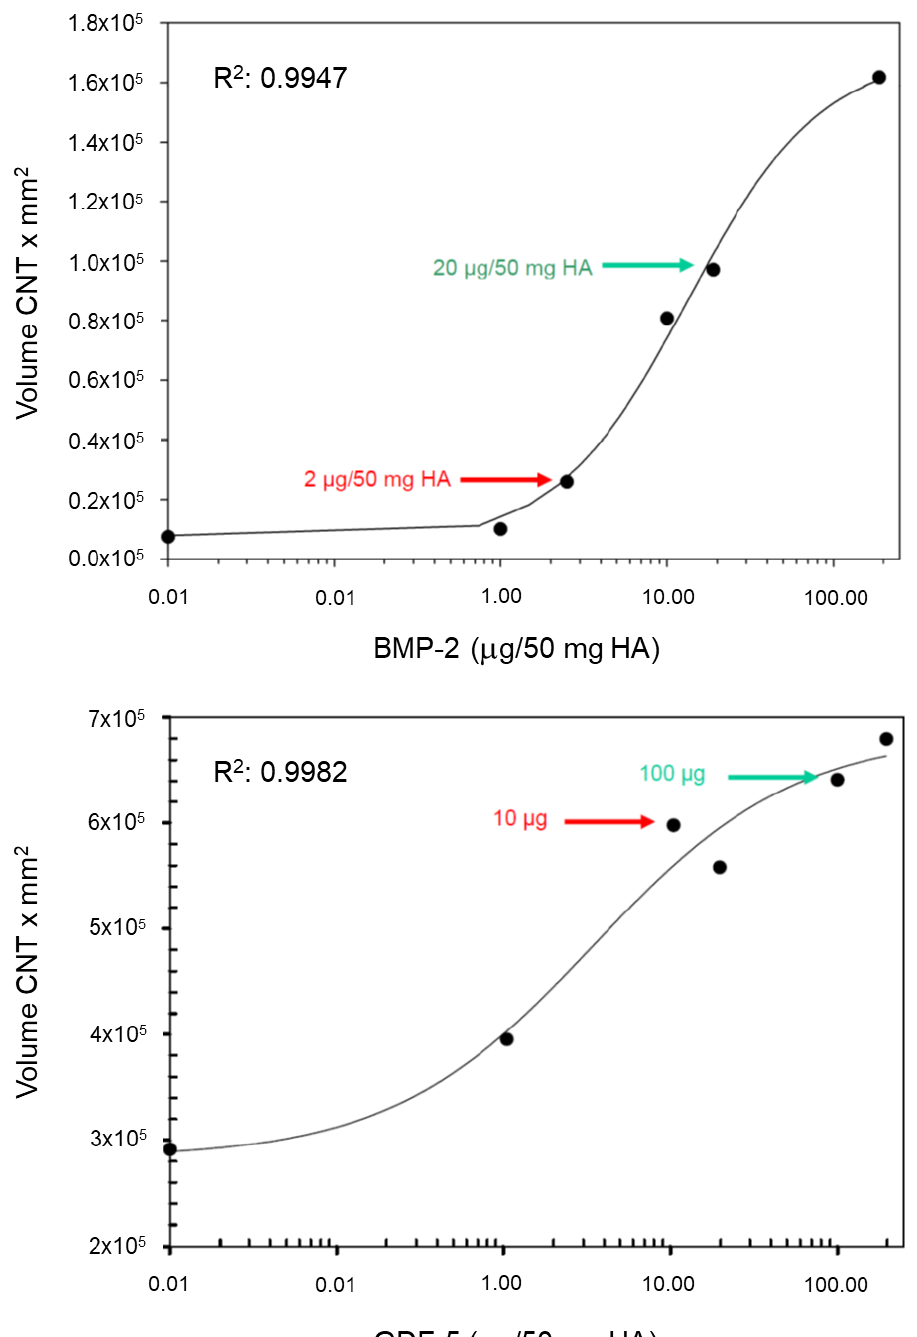
Figure 2. In vitro evaluation of the dosages for BMP-2 (C2C12 cell line; upper panel) and GDF-5 (ATDC-5 cell line; lower panel) for application in animal experiments by direct coculture with the growth-factor-coated HA particles for 3 days and subsequent determination of their alkaline phosphatase (ALP) activity ( n = 3–4 experiments each; one representative result is shown; y axes show the raw values of chemiluminescent reading). Derived therapeutic doses were 1 µg BMP-2/2.5 mg HA (low dose, lowest dose with a detectable effect; pharmaceutical formulation 2 µg BMP-2/5 mg HA; in vivo application of ½ dose) or 10 µg BMP-2/2.5 mg HA (high dose; half-maximal effect). Due to the presumably lower biological activity of GDF-5, doses for GDF-5 were 5 µg (low dose; half-maximal effect) and 50 µg (high dose; saturation effect).